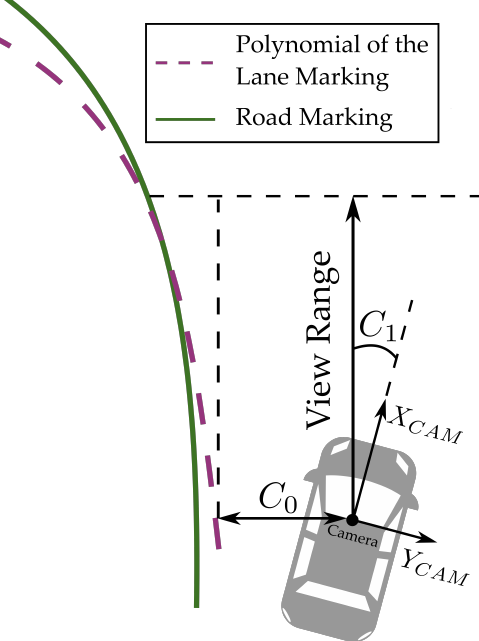
Figure 1. Illustration of lane marking